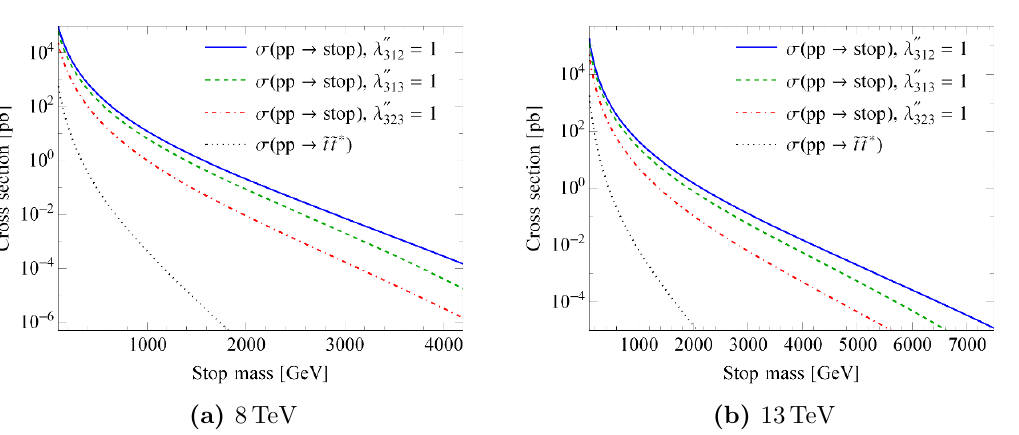
Figure 4. Stop production at centre of mass energy of 8 and 13 TeV. Here (cid:27) (pp ! stop) stands for (cid:27) (pp ! ~ t (cid:3) ) + (cid:27) (pp ! ~ t ). For resonant stop production, only one (cid:21) 00